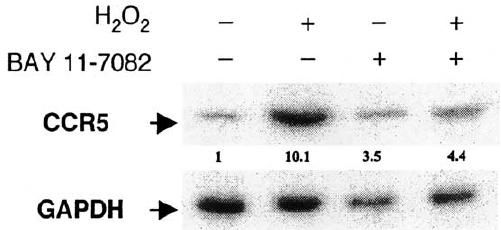
FIG. 5. Effect of BAY 11-7082 pretreatment on H 2 O 2 -induced CCR5 mRNA expression. Monocytes were incubated in the absence or presence of Bay 11-7082 (20 m M) for 30 min before addition of either medium or H 2 O 2 (200 m M). Total RNA was extracted and analysed by northern blot for the expression of CCR5 and GAPDH mRNA. The results are representative of three independent experiments.